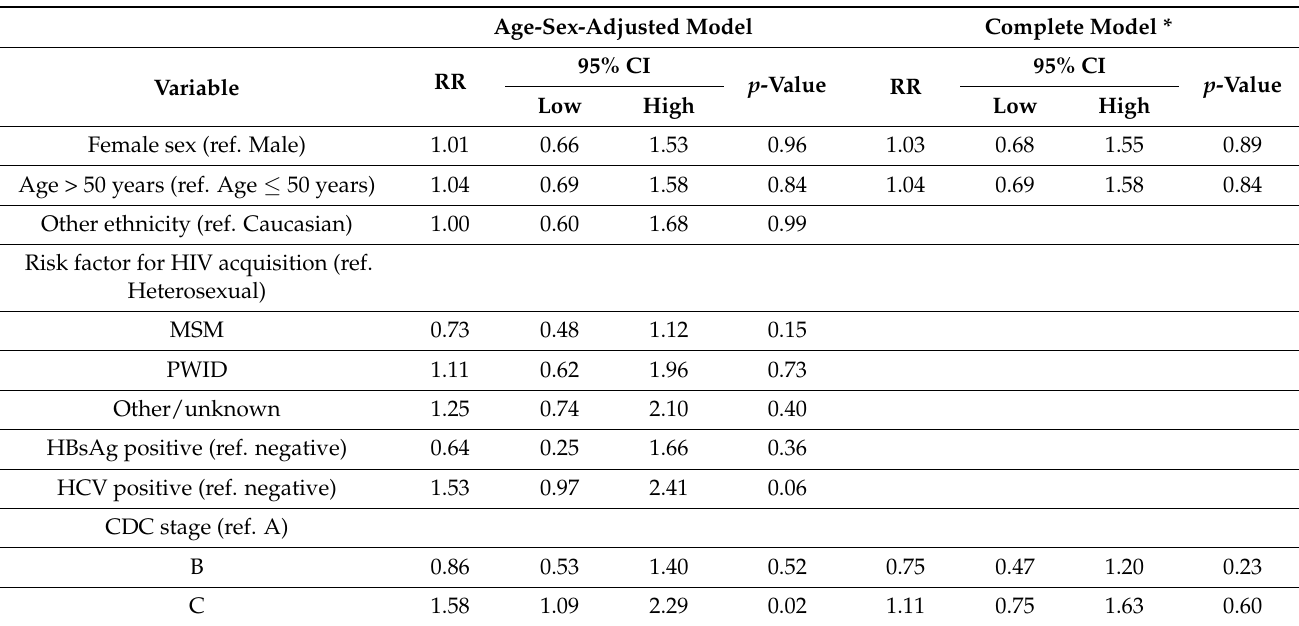
Table 4. Rate ratios (RR) and 95% confidence interval (CI) for any cause treatment interruption in 749 antiretroviral naive subjects during the first year of